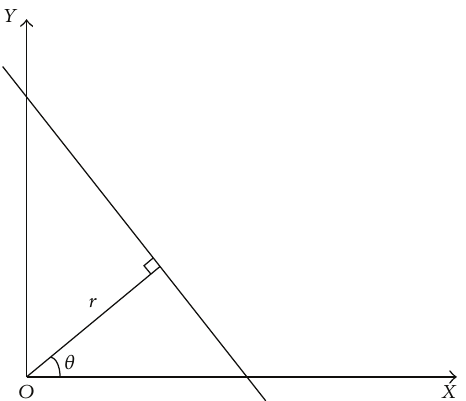
Figure 1: The pair of parameters (𝑟,𝜃) used in polar coordinates was used to replace the pair of parameters (𝑎,𝑏) used in Cartesian coordinates as the Hough parameter space.